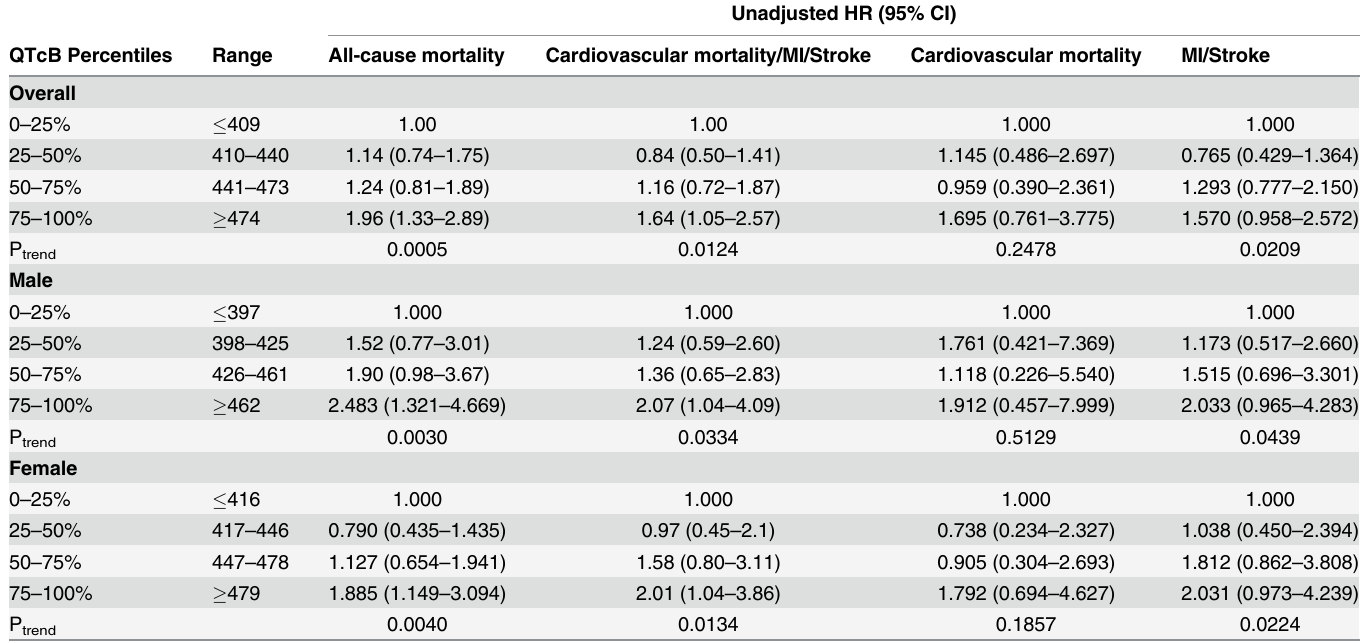
Table 2. Sex-stratified association of QTcB (categorical) with overall and cardiovascular mortality.